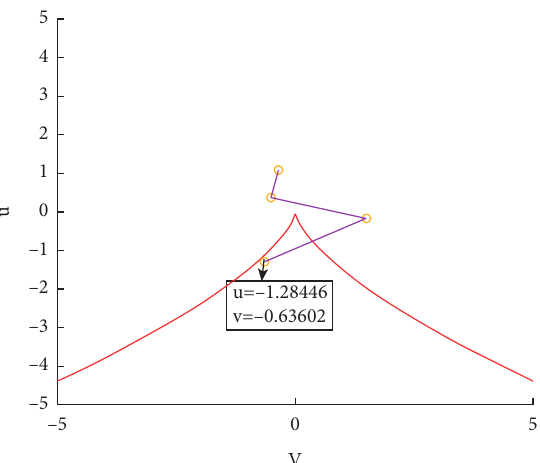
Figure 10: Plane projection chart of Shanghai crude oil futures price sudden change forecast.